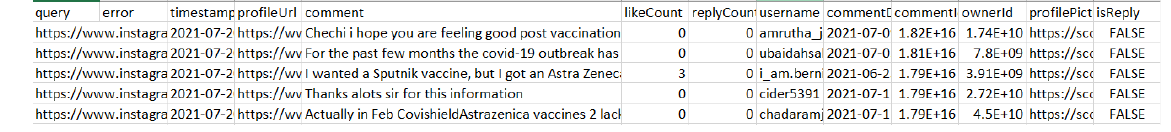
Figure 3. An excerpt from the “ comments ” dataset.